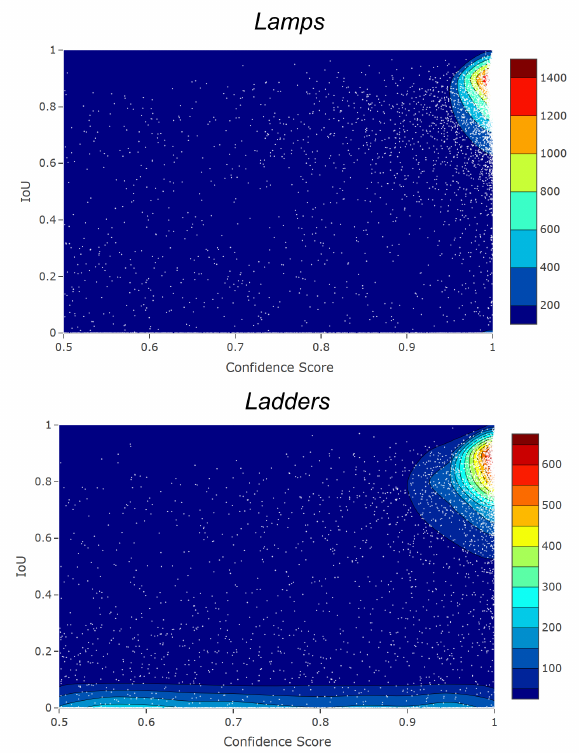
Figure 10. 2D density plot of things objects IoU and confidence, colored on a Jet palette; each white dot represent a predicted instance. Top: Lamps. Bottom: Ladders